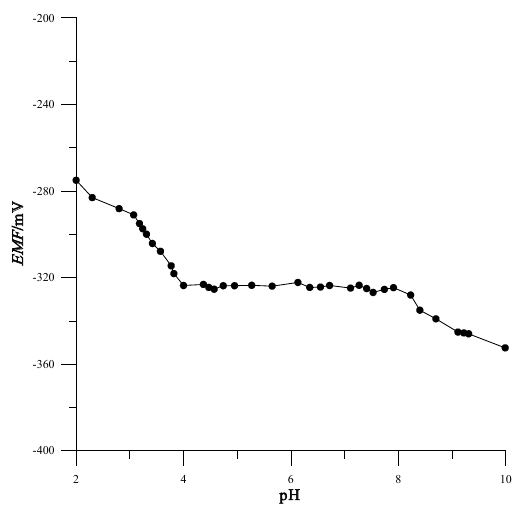
Figure 7. Effect of pH on the response of electrode 6b.